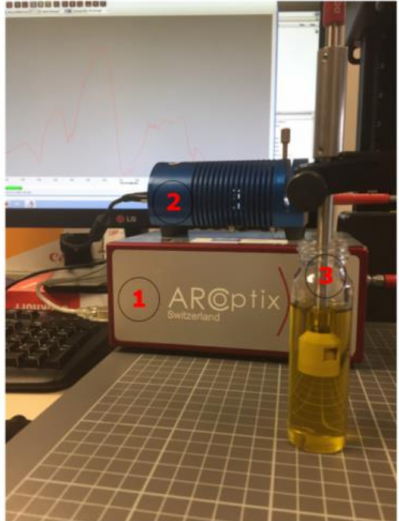
Figure 2. Hardware configuration labelled with numbers: (1) near infrared (NIR) sensor, (2) light source, and (3)